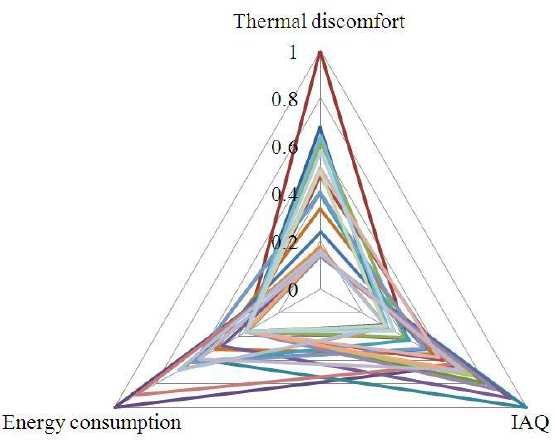
Figure 10. Radar diagram of the 23 best solutions identified by the optimization